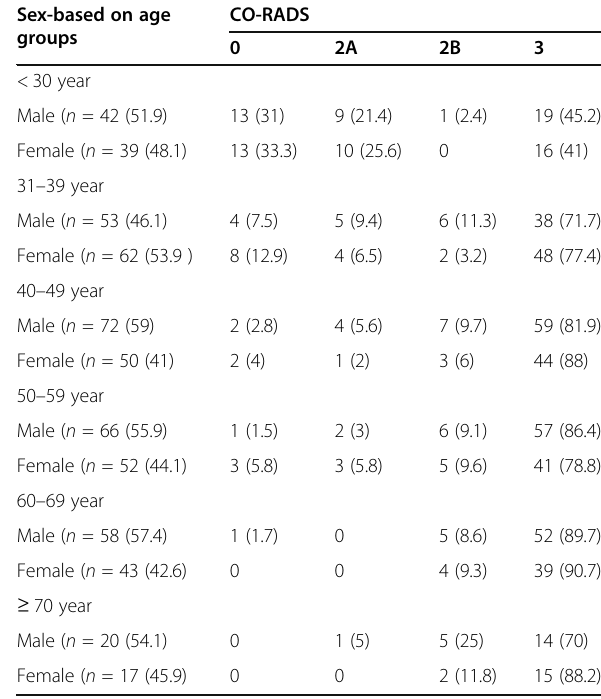
Table 3 COVID-RADS among the study population based